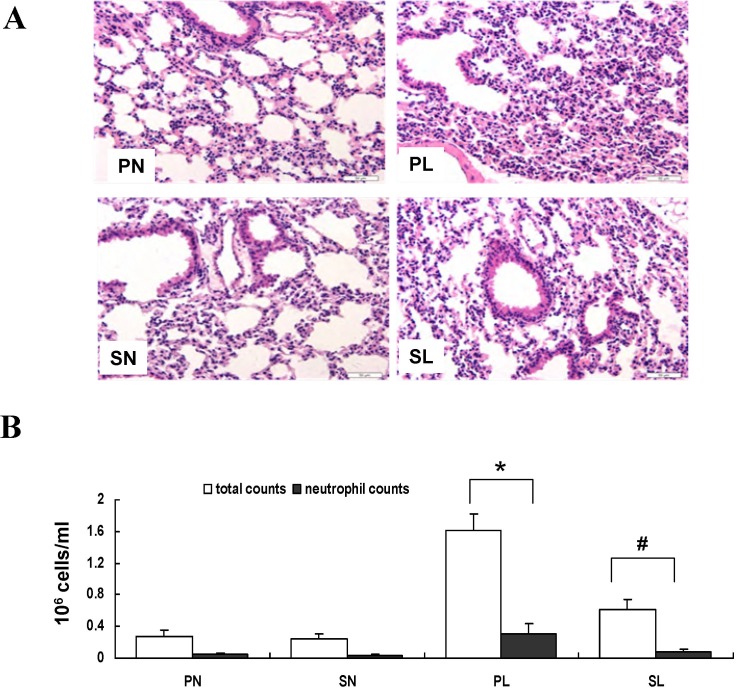
Effects of sevoflurane on histopathologic outcome and cell counts in bronchoalveolar lavage fluid (BALF) after LPS challenge in vivo.(A) Representative photomicrographs of lung sections stained with hematoxylin-and-eosin from mice anesthetized with phenobarbital or sevoflurane in the absence or presence of LPS challenge. The mice in group PN and SN showed much less inflammatory cell infiltration, alveolar septal thickening, and pulmonary edema in the lung compared with the mice exposed to LPS (NL+SL). Sevoflurane administered after intraperitoneal sensitization could mitigate lung inflammation upon re-challenge with LPS. Original magnification 100×. (B) Total cell and neutrophil counts in BALF. Data are presented as means ± SEM (n = 8 per group).*P < 0.05 versus PN; #P < 0.05, versus PL.